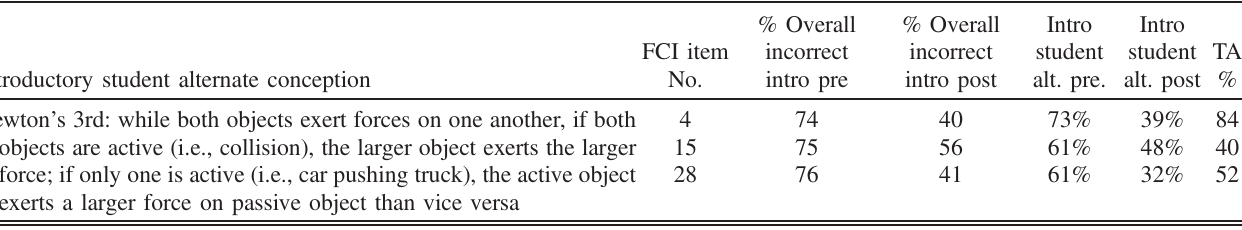
TABLE III. Contrasting examples (related to Newton ’ s 3rd law) of TAs ’ ability to identify introductory students ’ alternate conceptions. Questions on Newton ’ s 3rd law, percentage of introductory students who answered the questions incorrectly in the pretest and in the post-test, percentage of introductory students who hold the alternate conception in the pretest (Intro student alt. pre) and in the post-test (Intro student alt. post.), and percentage of TAs who identified the alternate conception. For convenience, brief descriptions of the FCI questions are